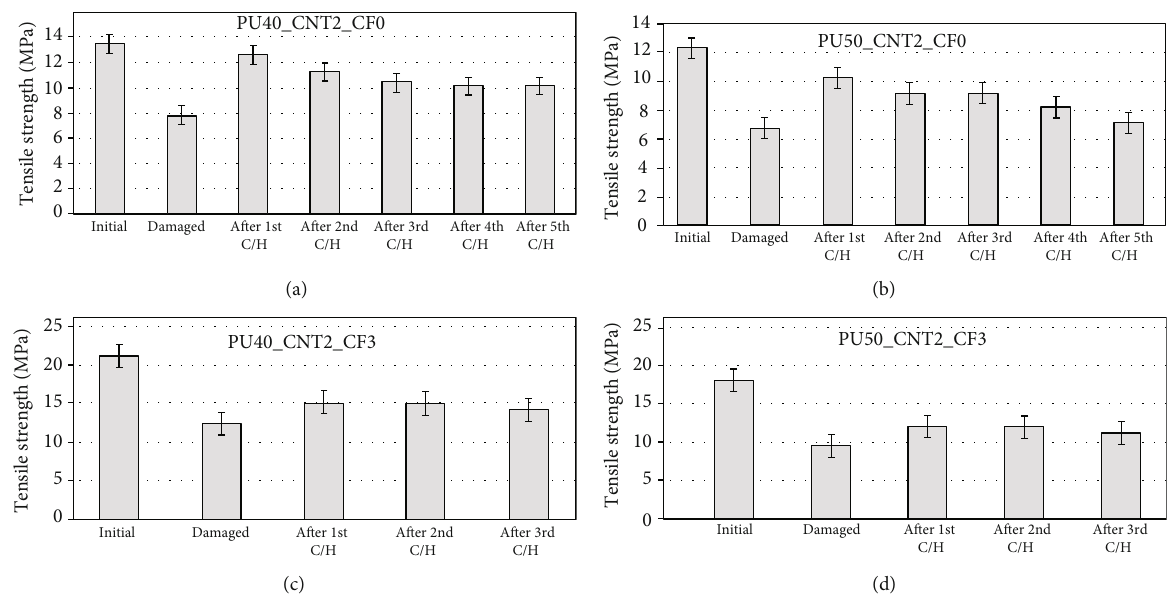
Figure 8: Changes in tensile strength of nanocomposites in the function of the number of C/H cycles.